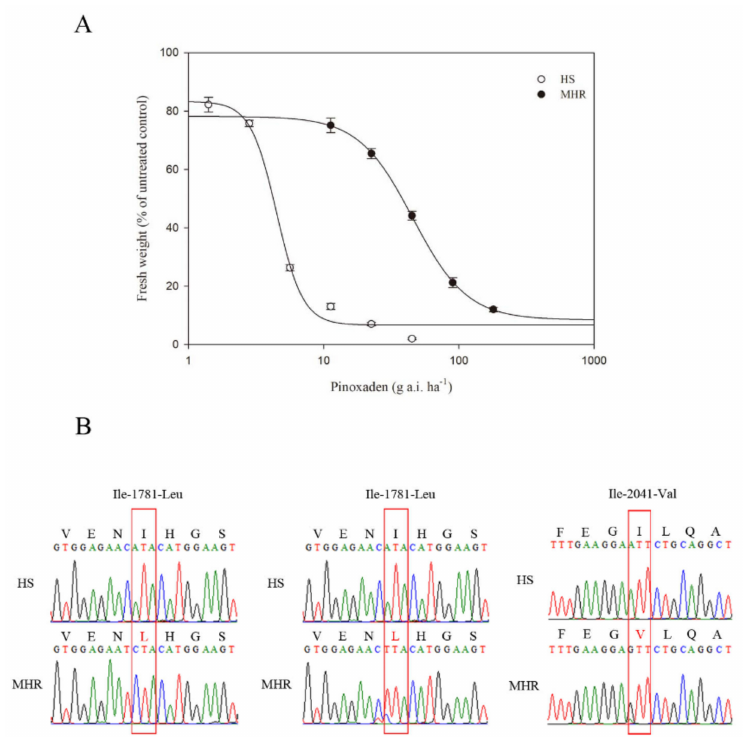
Figure 1. The MHR population is resistant to ACCase-inhibiting pinoxaden. ( A ) Percentage fresh weight with pinoxaden treatment in whole-plant dose–response assay. ( B ) Mutations in ACCase gene. Vertical bars represent the mean ± SE. Amino acid sequence positions refer to the sequence of ACCase from Alopecurus myosuroides Huds. (GenBank accession number AJ310767.1). Non-synonymous mutations are marked with red boxes. Table 4. Whole-plant dose–response